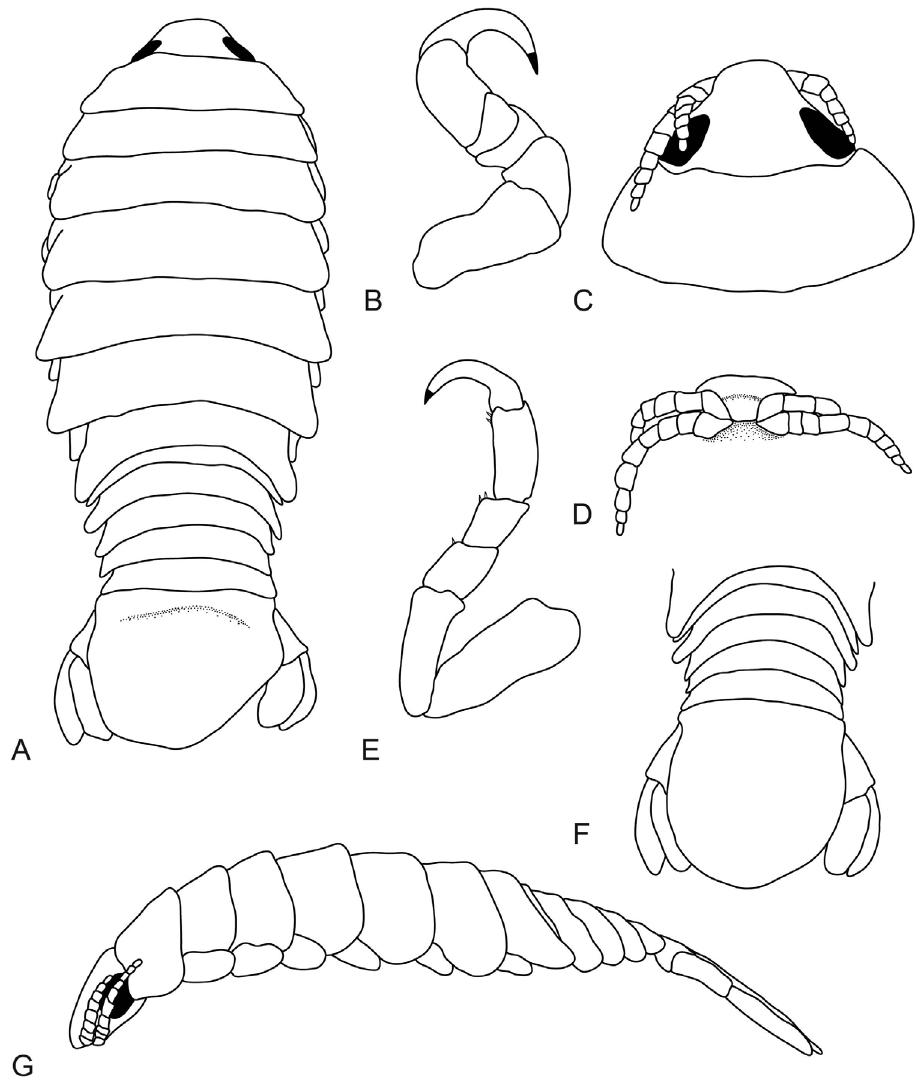
Figure 3. Anilocra haemuli transitional stage (12 mm): A dorsal view B pereopod 1 C dorsal view of cephalon D ventral view of cephalon E pereopod 7 F dorsal pleotelson G lateral view.